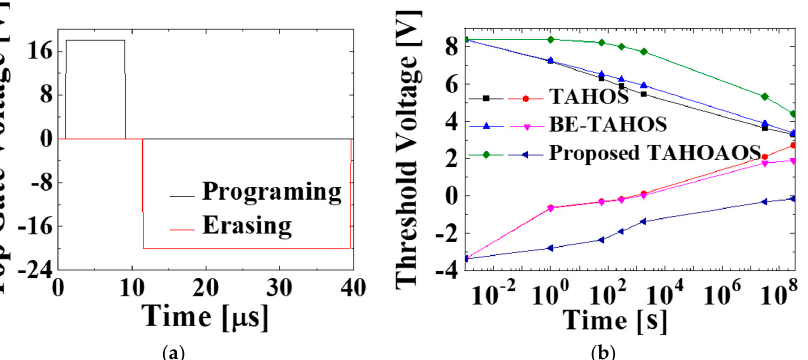
Figure 6. ( a ) Top gate bias during programming and erasing, and ( b ) retention characteristics of the conventional TAHOS, BE-TAHOS, and the proposed TAHOAOS structure. The high top gate voltage (17 V for programming and − 21 V for erasing) is applied in order to perform fair comparison by matching initial threshold voltage at 1 micro-second. (Specifically, programming with top gate voltage of 13 V, as in Table 2, results in different initial threshold voltage [37], and hence programming with a higher top gate voltage of 17 V is performed for fair comparison.).